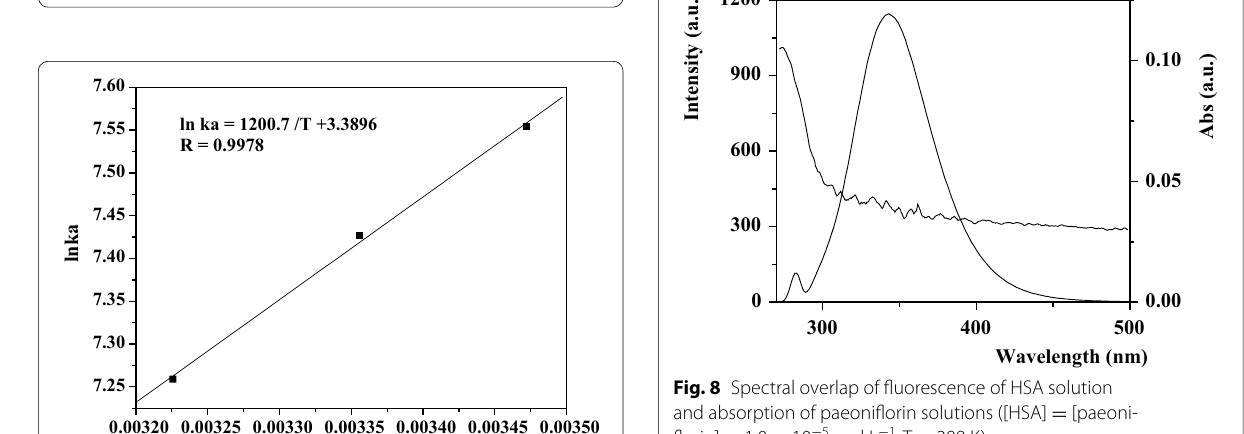
paeoniflorin solutions with + 10 − 5 to 1.25 10 − 5 mol L − 1 × ×